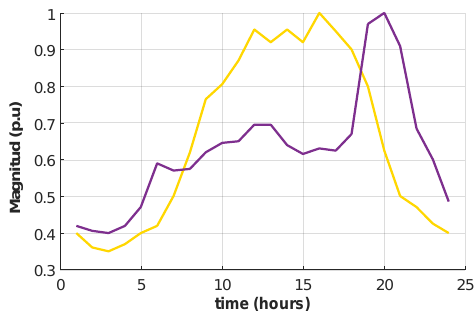
Figure 1. Residential (purple) and industrial (yellow) typical daily load profiles.